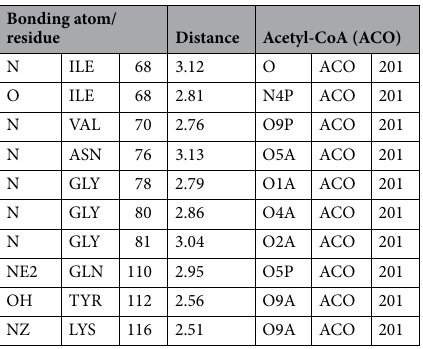
Table 2. Hydrogen bond interactions between GNAT acetyltransferase from Elizabethkingia anophelis and acetyl-CoA.